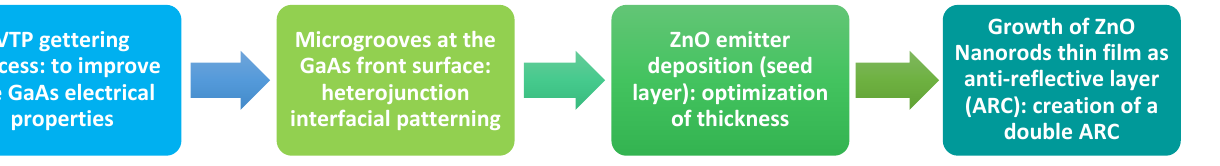
Figure 1. The fabrication sequence of the n-ZnO/p-GaAs heterojunction: the effect of each stage on the performance of the heterojunction was investigated. The final stage corresponds to the combination of all these effects that was carefully optimized.